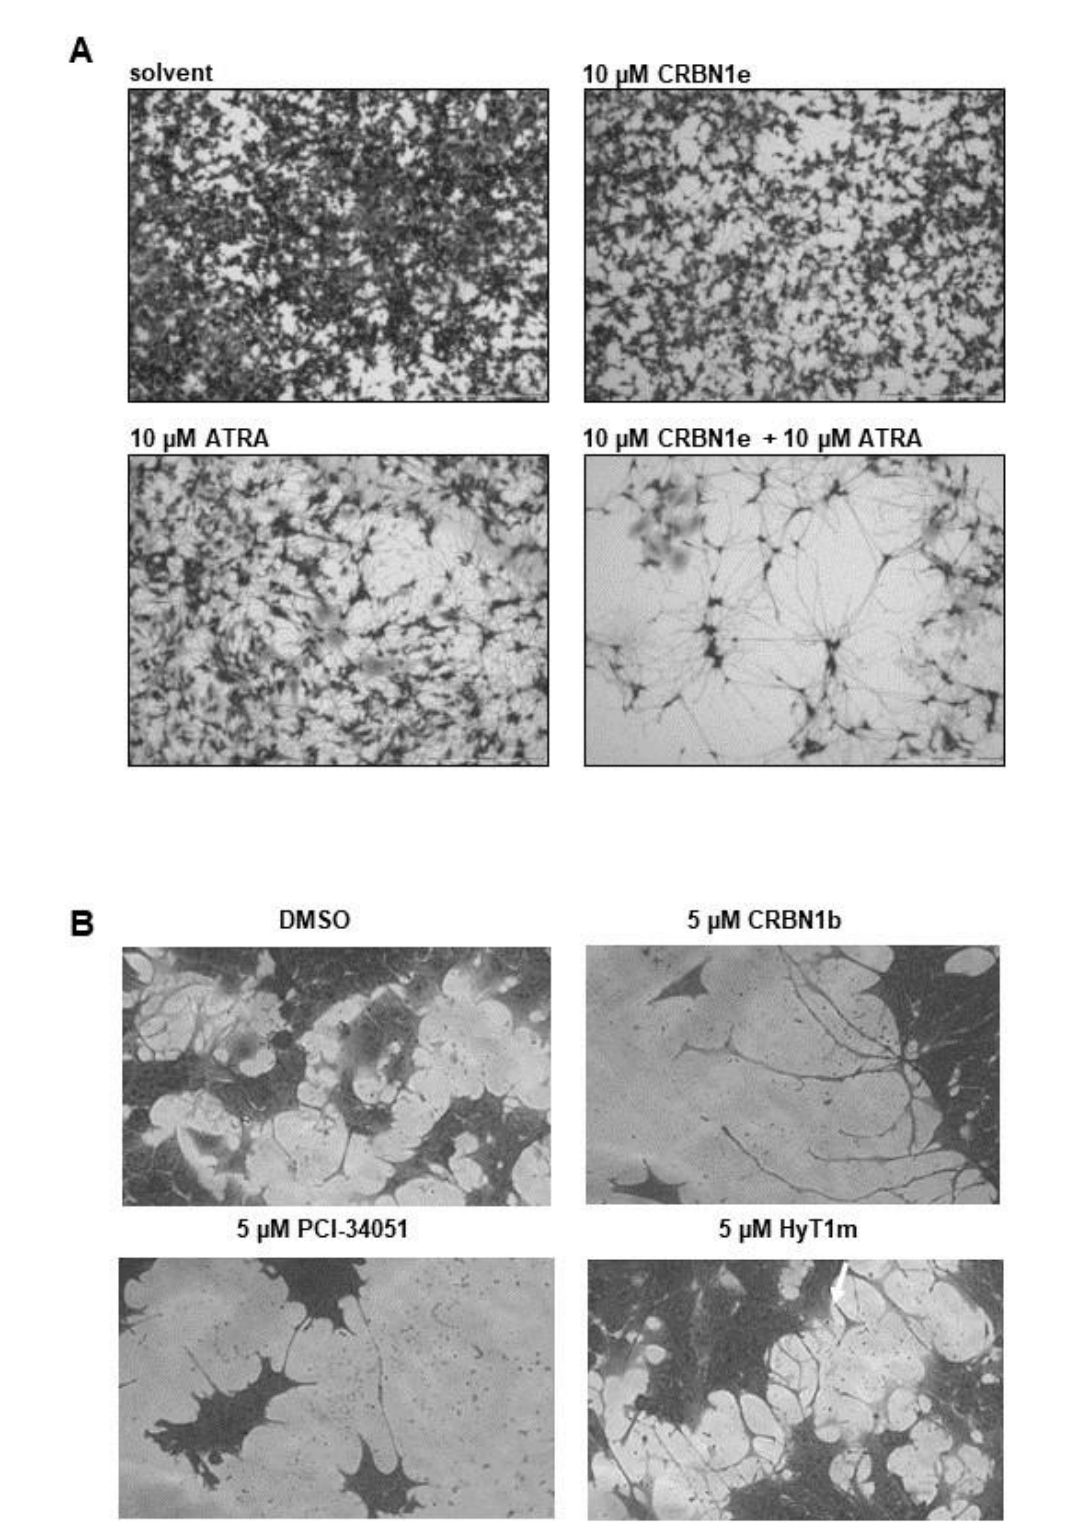
Figure 7. ( A ) SK-N-BE(2)-C cells, treated for 10 days. Scale bar: 500 µ m. Stained with crystal violet. ( B ) SK-N-BE(2)-C cells, treated for 6 days. Stained with crystal violet.